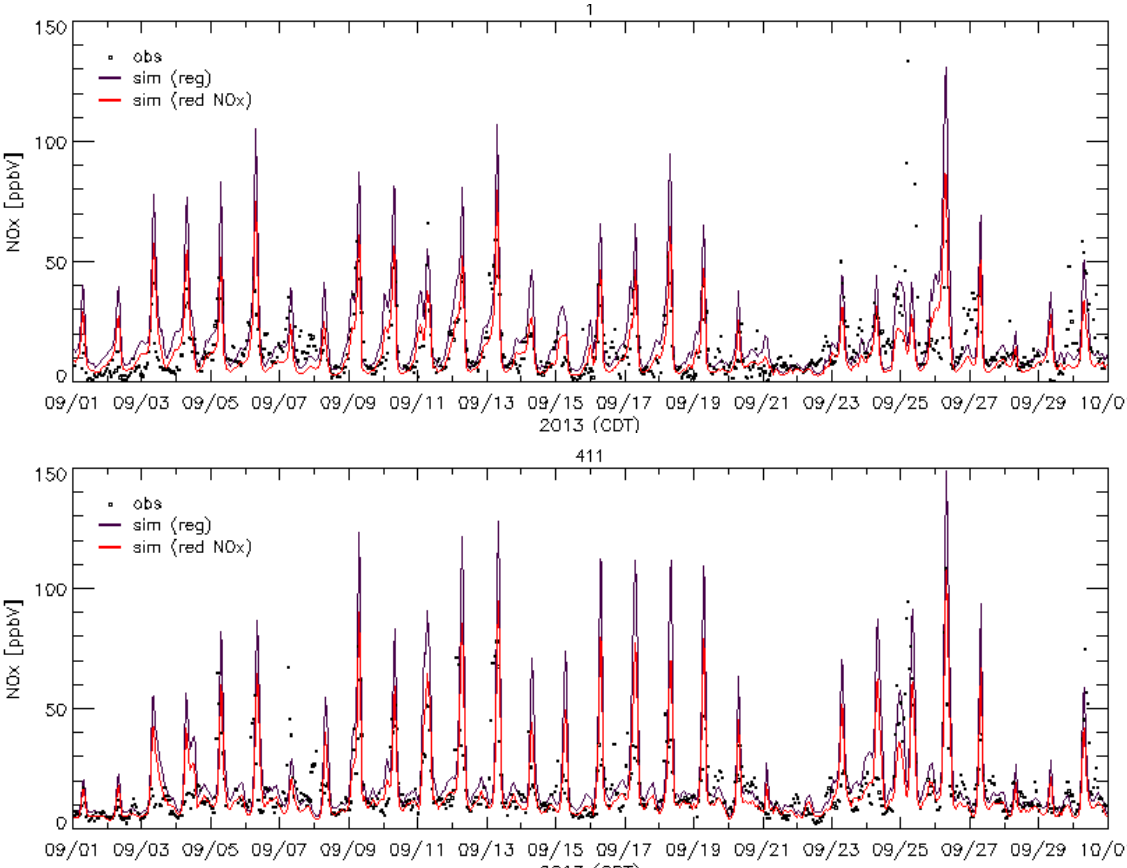
Figure 2. Time series comparing measured NO x against values simulated with the base case and the reduced NO x case at CAMS sites 1 (top) and 411